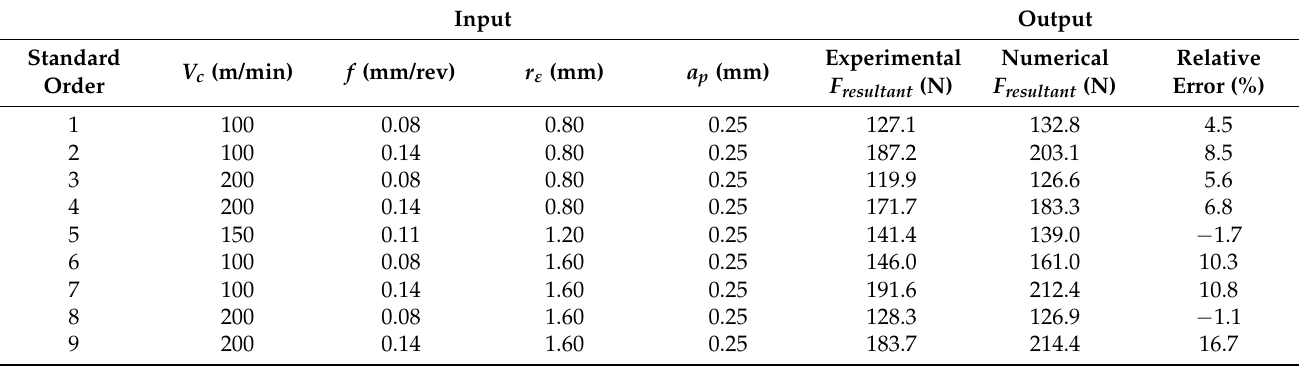
Table 3. Resultant machining force comparison between experimental and numerical